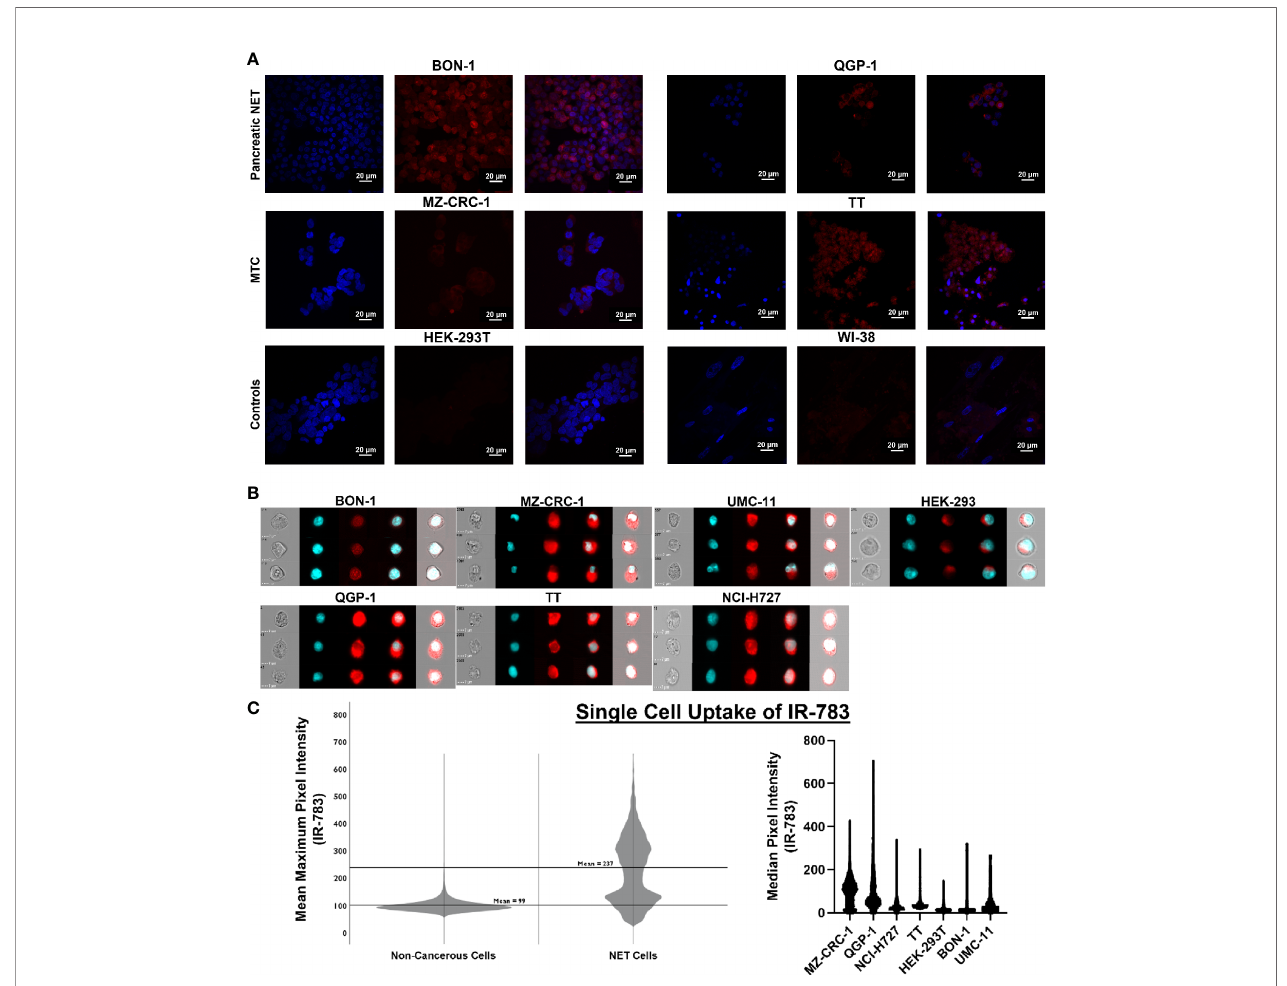
FIGURE 4 | Single cell uptake of IR-783 is higher in NET cell lines than non-cancerous cell lines. (A) Confocal microscopy of human NET cell lines (BON-1, QGP-1, MZ-CRC-1, TT) and non-cancerous control cell lines (HEK-293T, WI-38) incubated with IR-783 (center) and stained with DAPI (left) demonstrated higher uptake of IR-783 in NET cells. IR-783 and DAPI stains are overlaid to depict localizaiton of IR-783 within the cells (right). (B) Human NET cell lines (BON-1, QGP-1, MZ-CRC-1, TT, UMC-11, NCI-H727) and non-cancerous controls cells (HEK-293T) were incubated with IR-783 and imaging fl ow cytometry was performed. (C) NET cell lines exhibited signi fi cantly higher median pixel intensities than non-cancerous cells (MZ=103.1, QGP-1 = 63.7, NCI-H727 = 50.6, BON-1 = 30.3, UMC-11 = 22.7, TT=73.6, and HEK-293T=11.9; p = <0.001). NET cells also exhibited higher mean maximum pixel intensity (237) than non-cancerous control cells (99) (p =